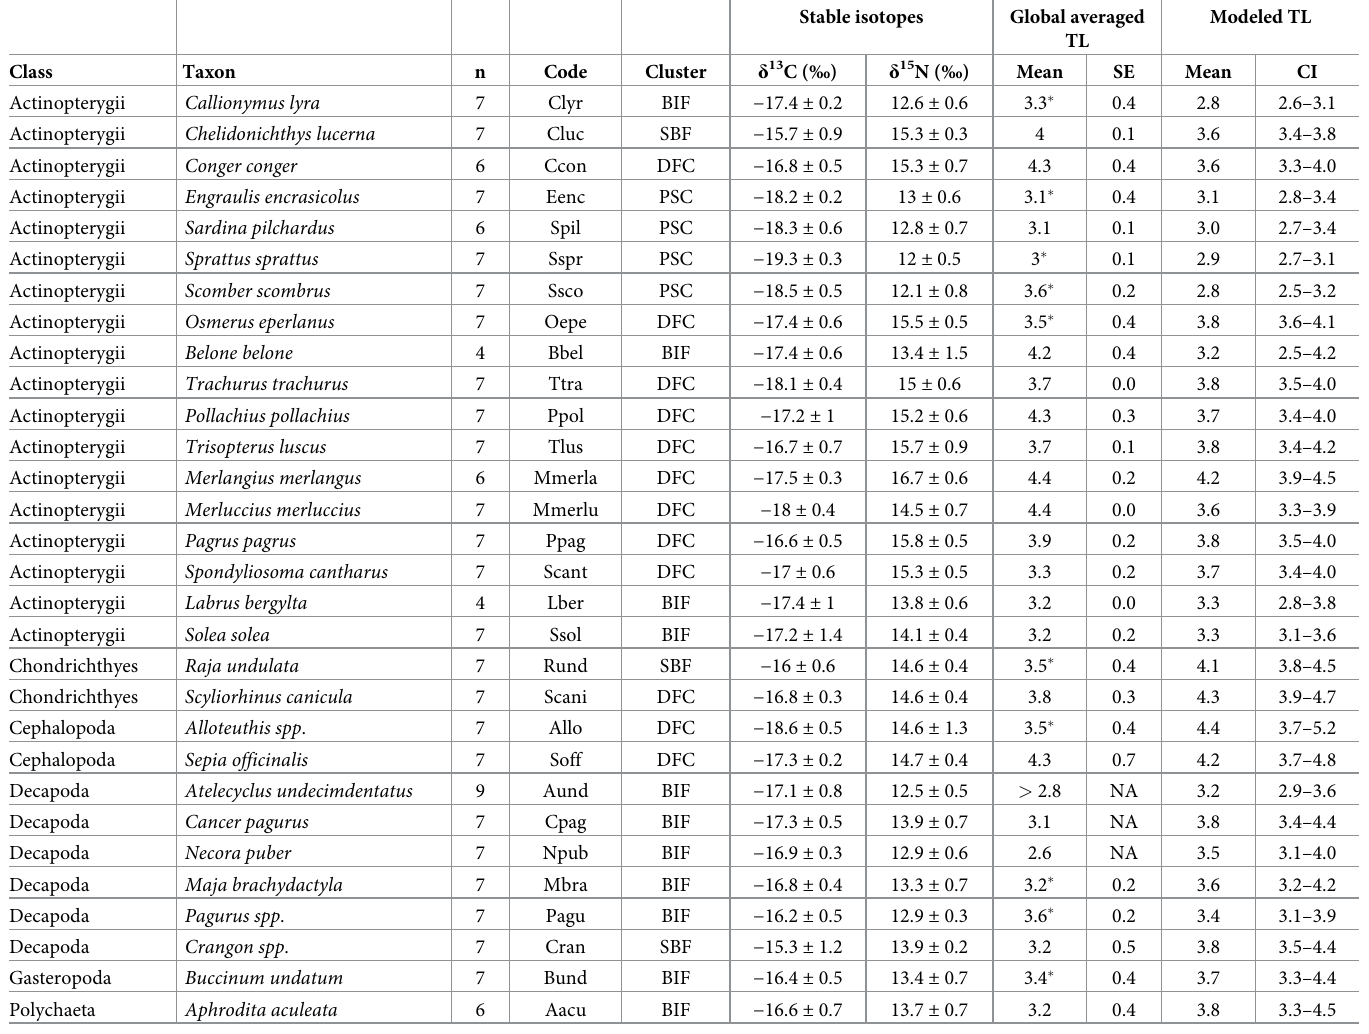
Table 1. Comparison between global averaged trophic level (TL) and TL modeled from isotopic composition of the 30 consumers. Global averaged TL are presented as mean ± SE and derived from fishbase and sealifebase databases, except for Cancer pagurus and Necora puber which are derived from seaaroundus database. Modeled TL are provided as mean and 95% credible intervals (CI) and calculated using tRophicPosition R package. ‘n’ = sample size. ‘Code’ = simplified taxa names used in figures. ‘Cluster’ = trophic group according to UPGMA